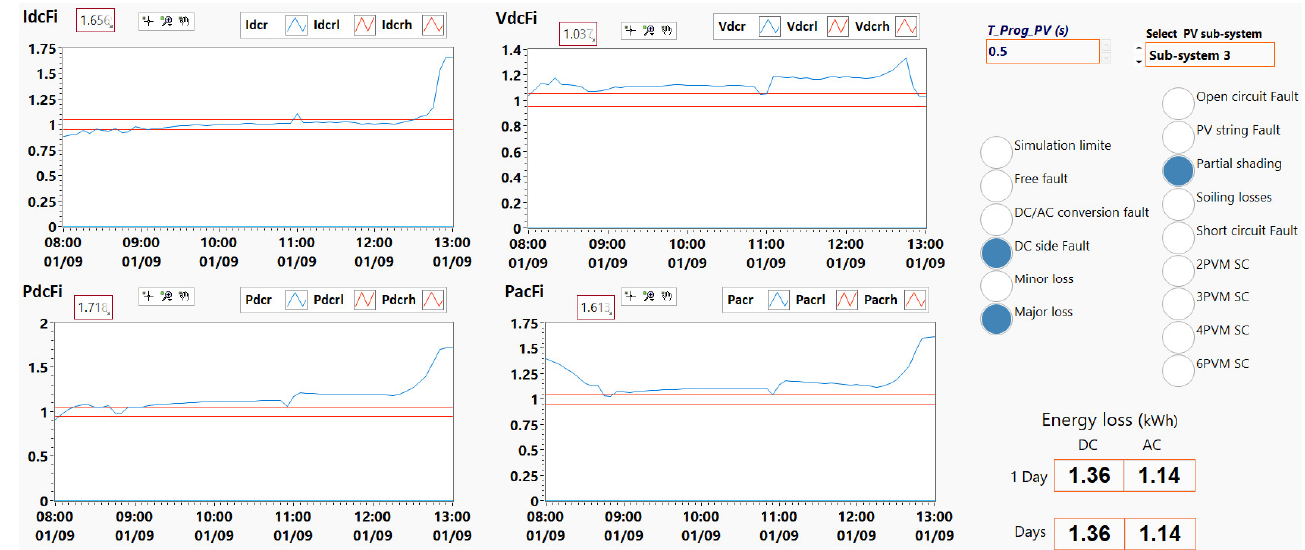
Figure 30. Localization of the temporary partial shading fault caused by pylon.